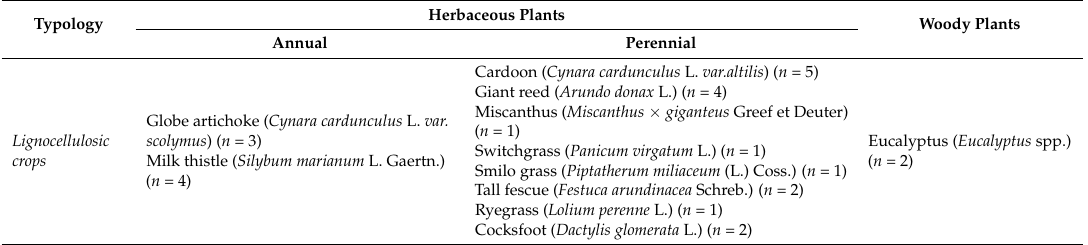
Table 1. Summary of the different typologies of biomass crops analysed. In brackets the number of